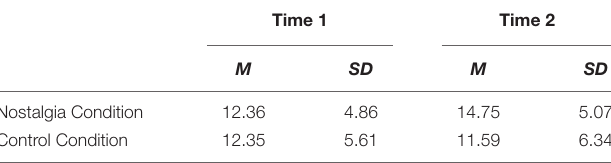
TABLE 2 | Pain tolerance scores as a function of nostalgia